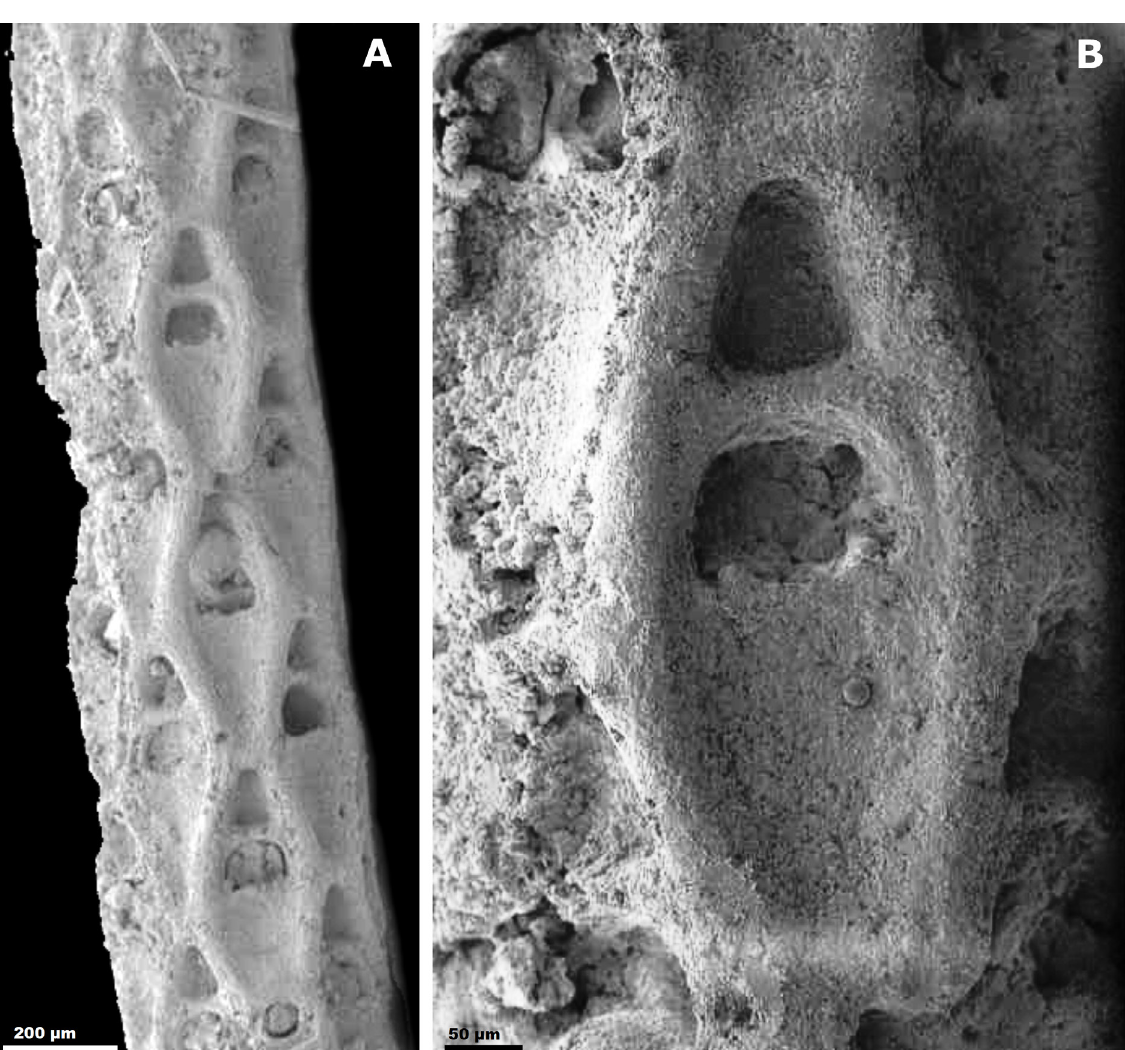
Fig. 8. Cellaria sp. (GIS/B 0515). A . General view of the colony showing hexagonal autozooids. B . Close-up of a single autozooid showing semicircular orifice with a pair of strong denticles, depressed proximal cryptocyst and distally placed ooecial